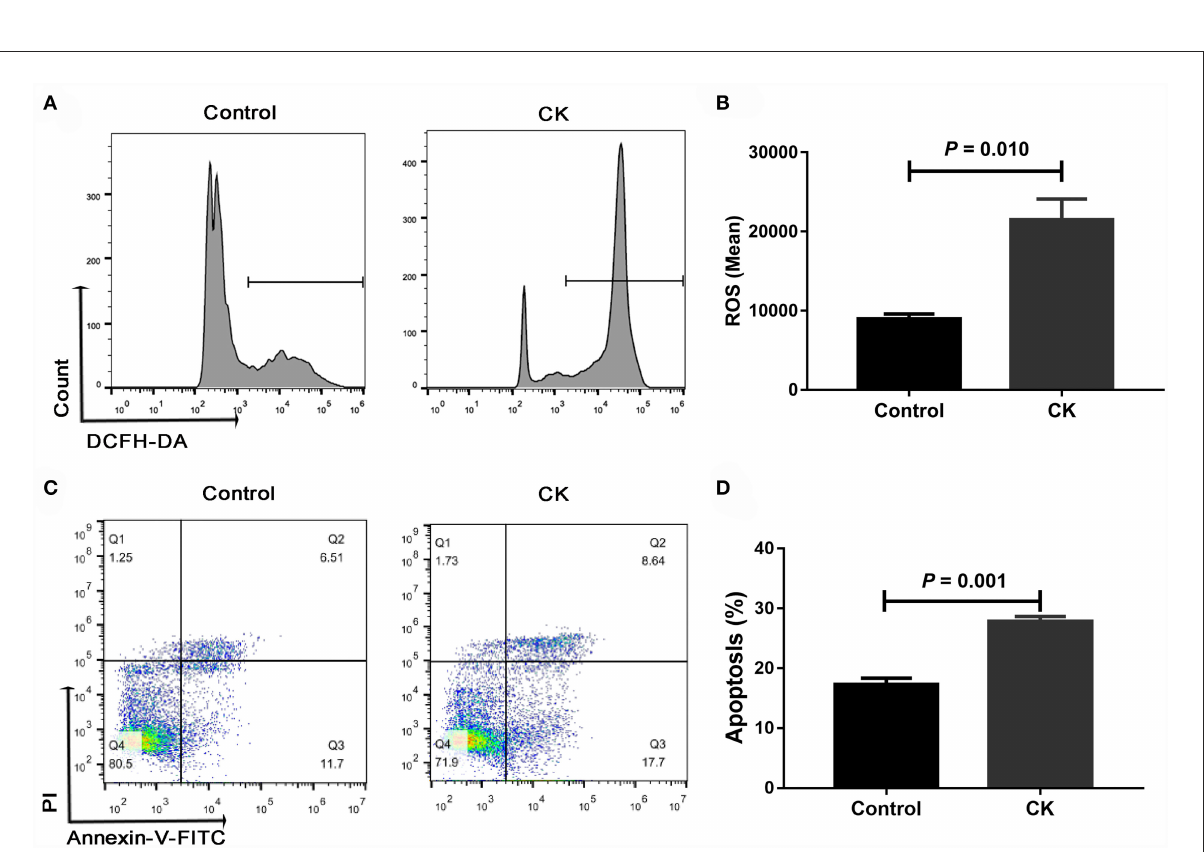
FIGURE3 Reactive oxygen species (ROS) content and apoptosis of CD14 + monocytes from healthy cows ( n = 12), and clinically ketotic cows (CK, n = 12). (A,B) ROS content in monocytes. (C,D) Apoptosis of monocytes. Data were analyzed with paired t -tests and reported as means ± SEM of three independent